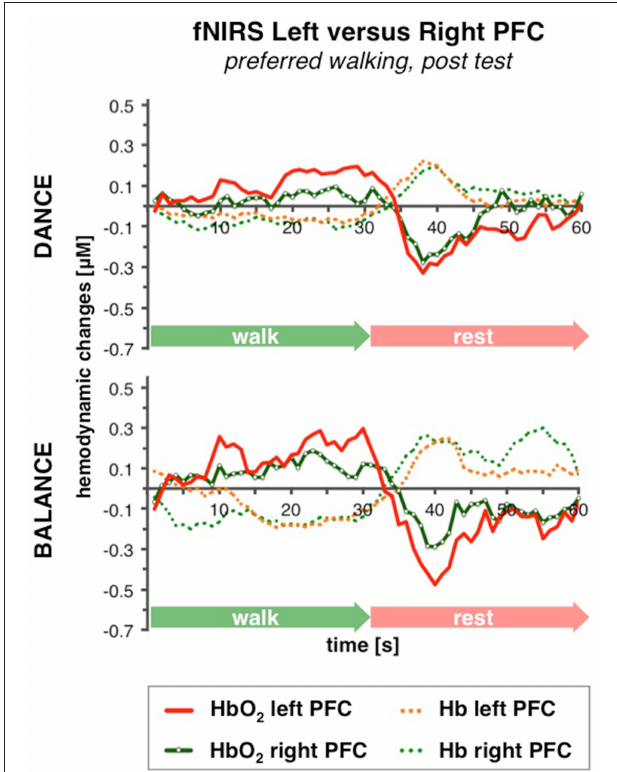
FIGURE 5 | Comparison of left vs. right PFC activity. Graphs represent time-triggered group averages. Identical line color and style in Figures 4 – 6 represent the same data. Within the timeframes t10–25 and t26–34 left PFC activity was higher than right PFC activity in DANCE and BALANCE. No differences in left vs. right PFC activity during walking were present at pre-test (graphs not shown). DANCE, video game dance training; BALANCE, balance and stretching training, PFC, prefrontal